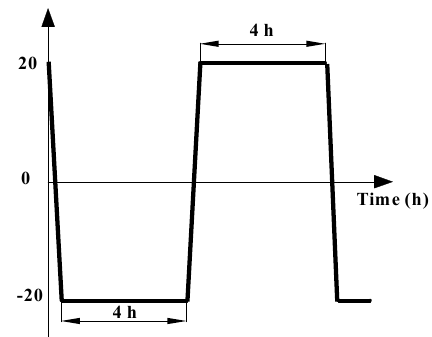
Appl. Sci. 2021 , 11 , x FOR PEER REVIEW Figure 3. Temperature curve of one freeze–thaw cycle. Figure 3. Temperature curve of one freeze–thaw cycle.